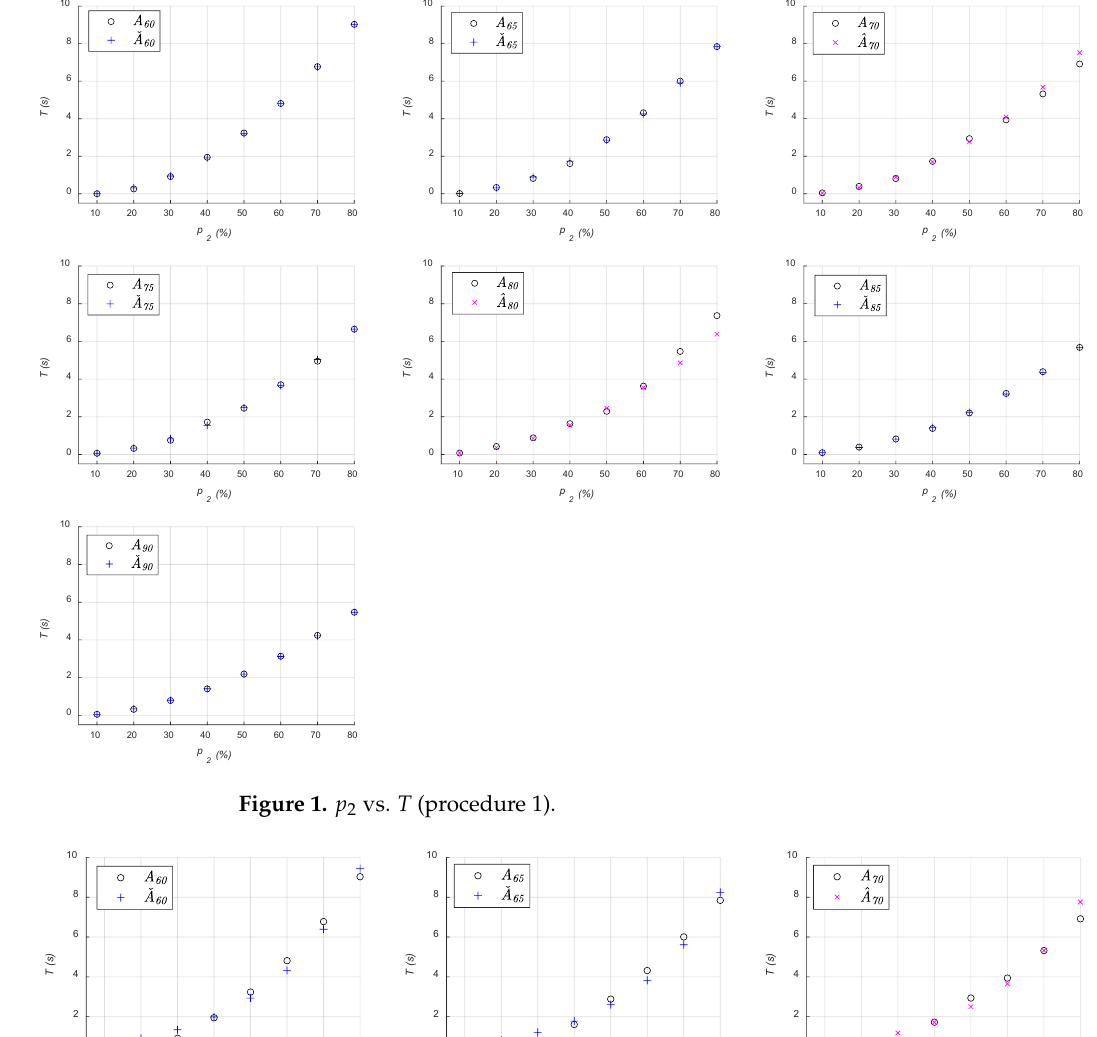
is comparable to 𝐴𝐴̌ 𝑠𝑠𝑠𝑠 1